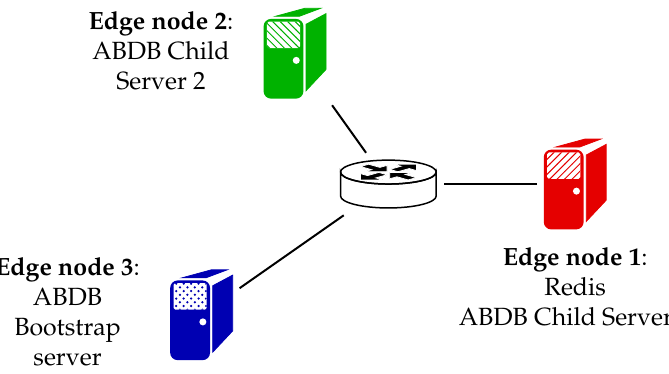
Figure 6. Experimental edge and network setup with three edge nodes.